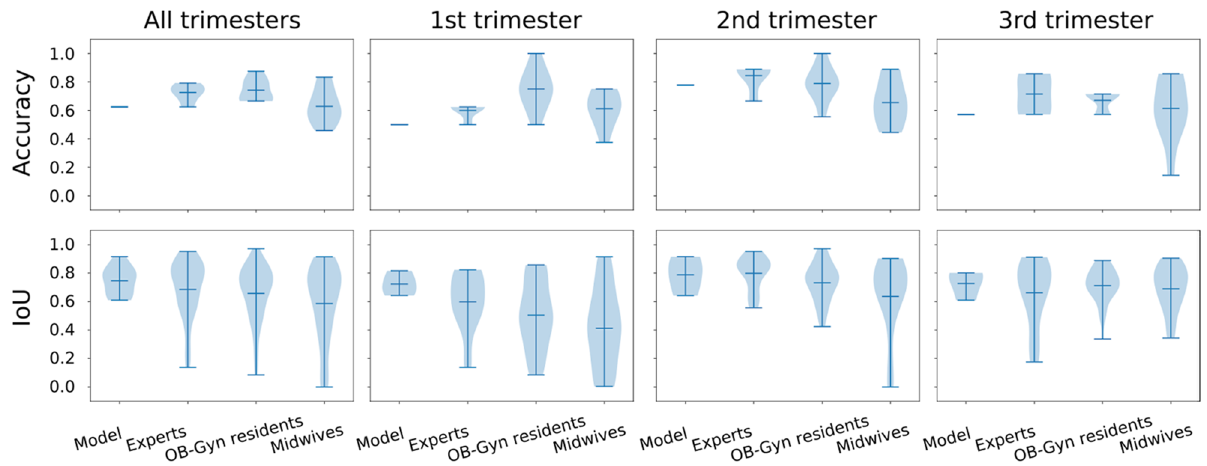
Figure 2. Violin plots of classification accuracy distributions (first row) and distribution of segmentation performance measured by IoU (second row) for different groups across